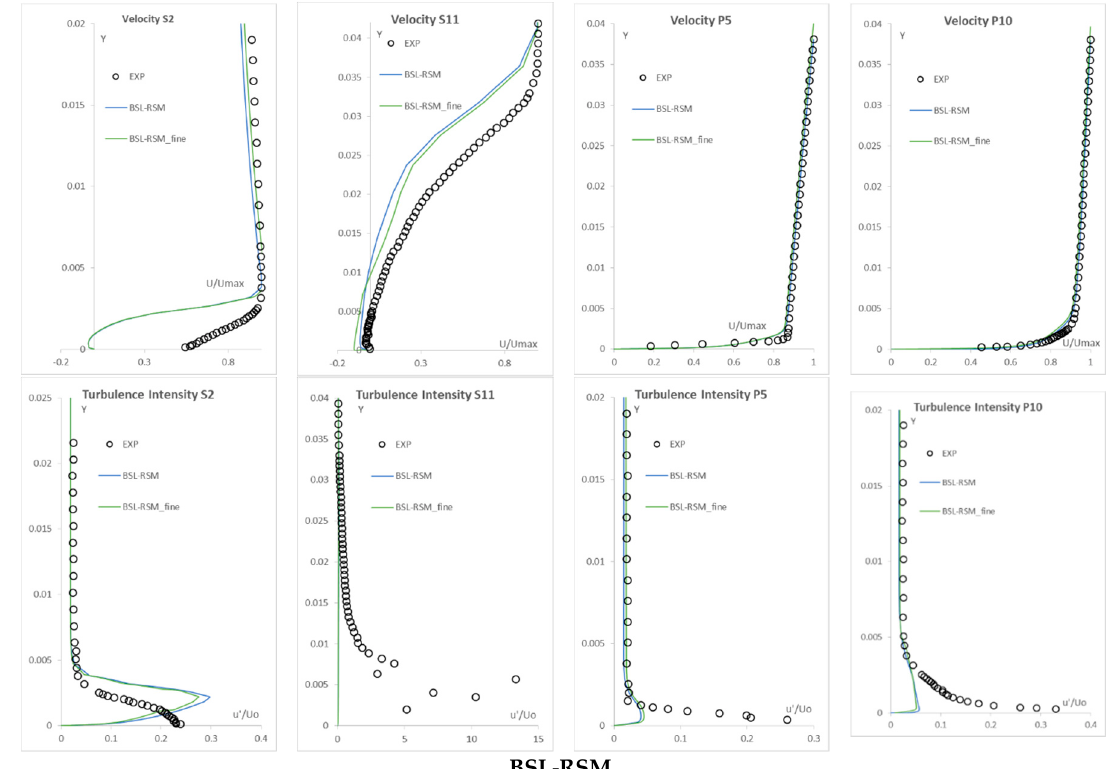
Figure 3. Velocity and turbulence intensity distributions for the base and fine computational grids for the Spalart and Allmaras [14] model (SA), Shear Stress Transport model (SST), and Baseline Reynolds Stress model (BSL-RSM) (measurement stations are shown in Figure 4).